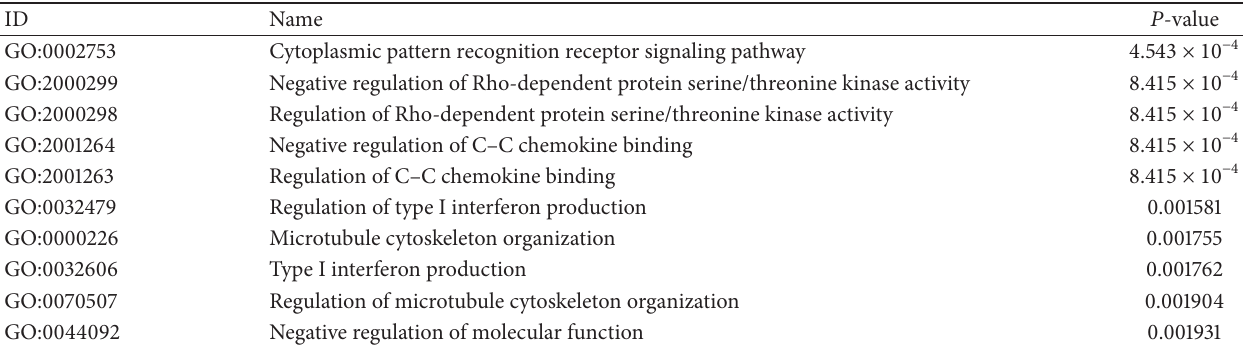
Figure 10: Graphical representation for tricluster TC 2 found in the Human GDS4472 Dataset. Table 14: GO analysis for tricluster TC 2 in Human GDS4472